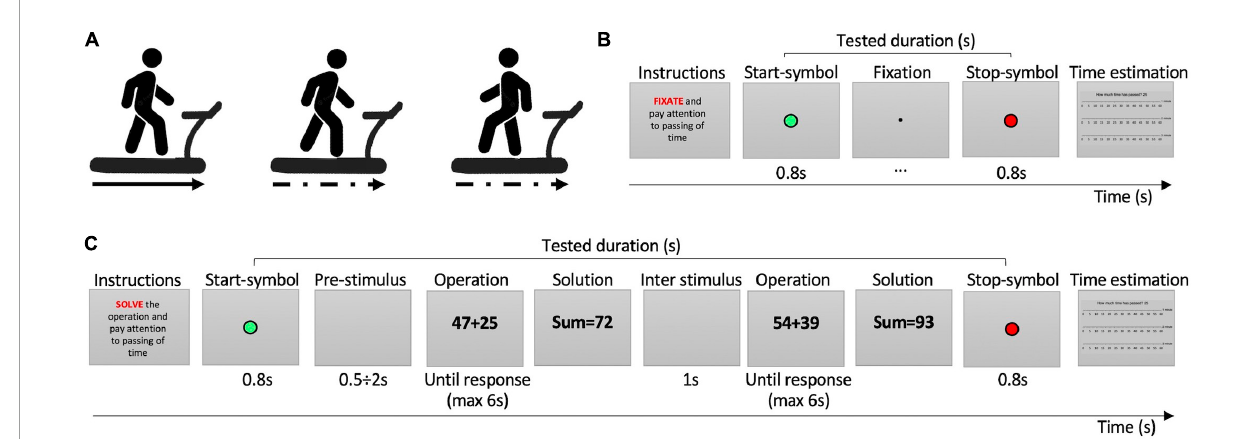
FIGURE1 Procedure and tasks. (A) Motor conditions. From left to right: forward regular-speed walking, forward irregular-speed walking, backward irregular-speed walking. (B) Easy task. (C) Hard task. In the instructions, the red word indicates the cognitive task to be performed. The green circle indicates the beginning of time estimation; the red circle indicated the stop of time